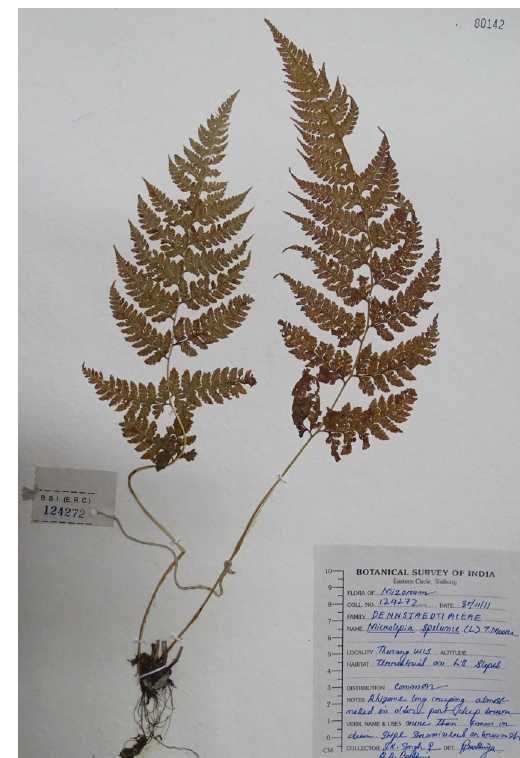
Image 16. Cyathea gigantea